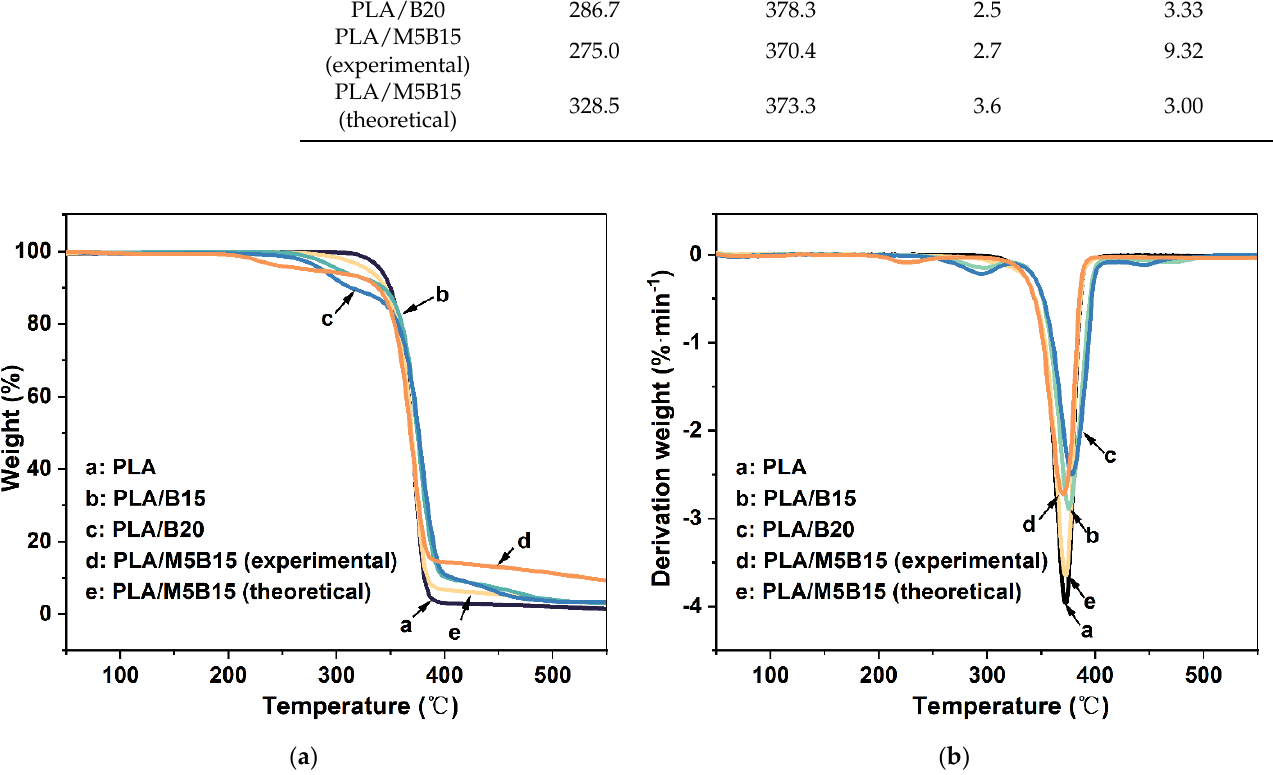
Figure 5. The TG ( a ) and differential thermogravimetric (DTG) ( b ) curves of PLA composites. Table 5. Related thermal degradation parameters of PLA and PLA composites.